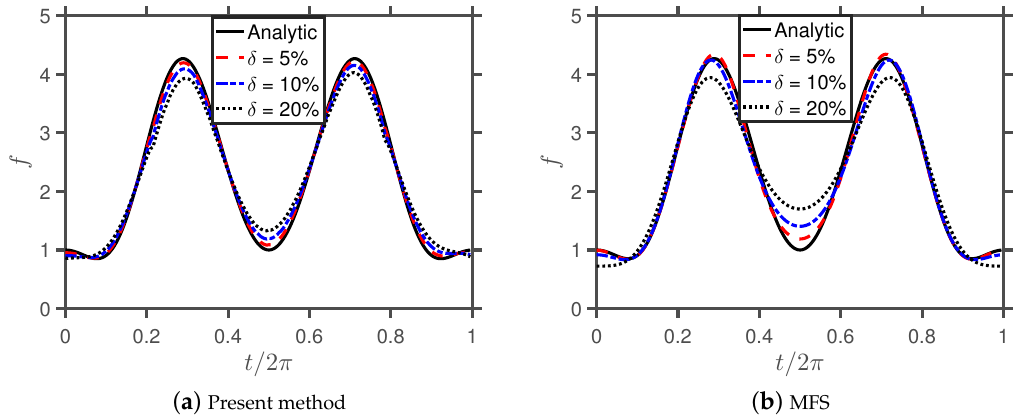
Figure 6. The numerical solutions with various amounts of noise added in the boundary data of Example 4, on ∂ D .